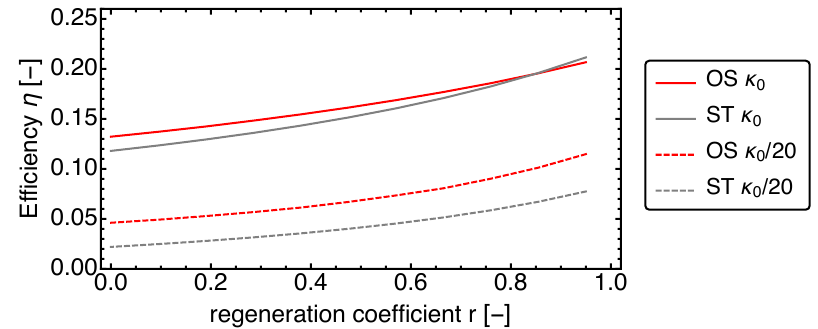
Figure 6. The efficiency is shown as a function of the regeneration coefficient r for the reference case in comparison with the low mass transfer case . For both cases the efficiency is clearly decaying with weaker regeneration. Moreover the efficiency for the standard motion is larger than for the OS motion close to perfect regeneration for the reference case . Note that the efficiency for the OS motion is improved by factors on the order of 5 compared to the ST motion for the low mass transfer case .